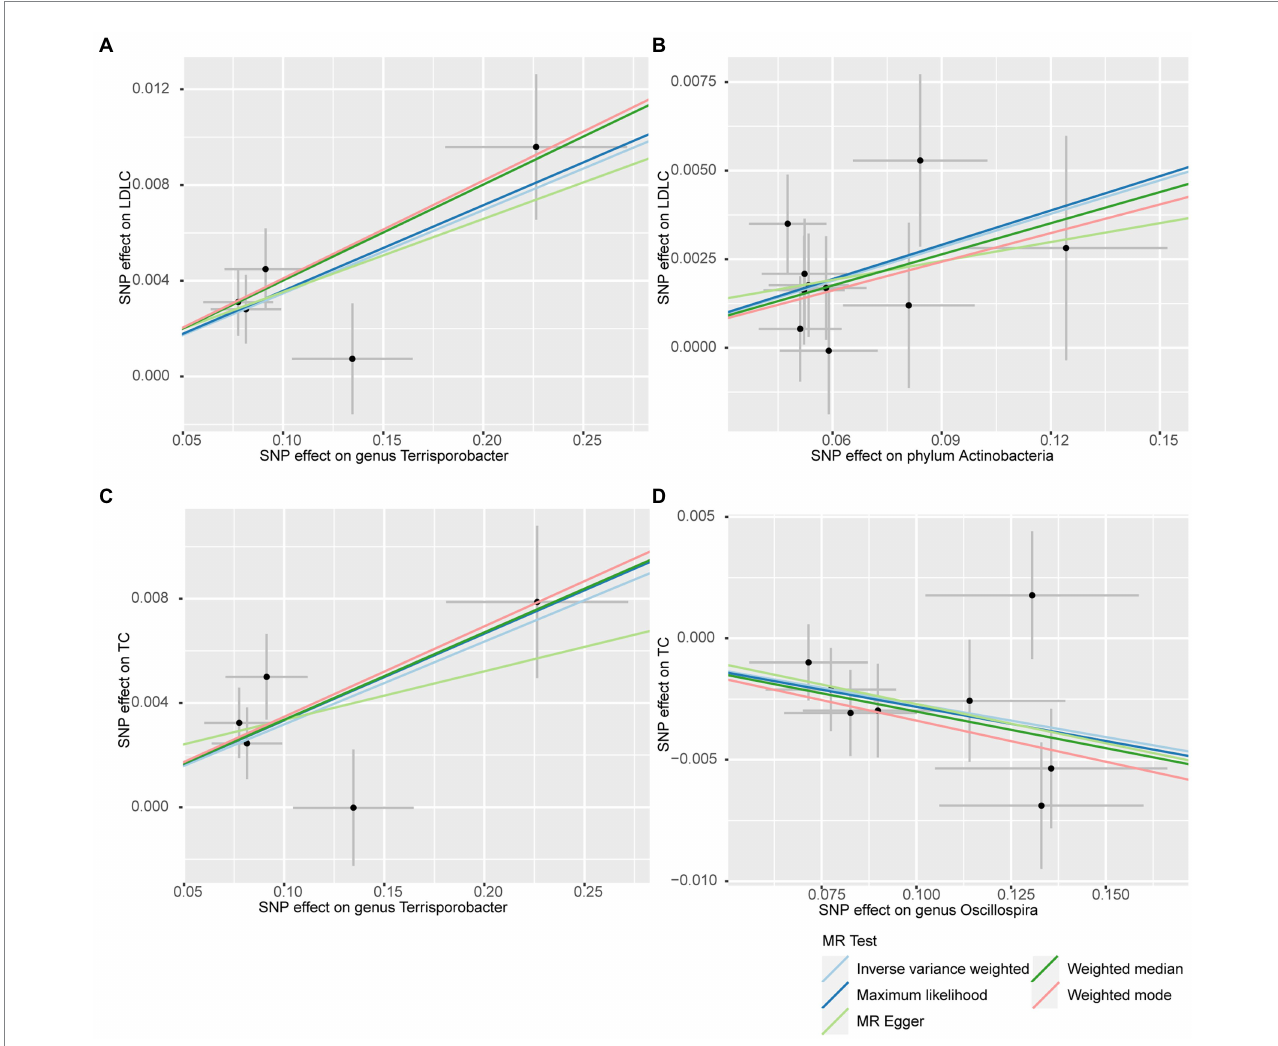
FIGURE 3 Scatter plots for the causal effects of the identified bacterial taxa on serum lipids. (A) Terrisporobacter (genus)–LDL-C. (B) Actinobacteria (phylum)–LDL-C. (C) Terrisporobacter (genus)–TC. (D) Oscillospira (genus)–TG. (Light blue line: inverse-variance weighted; blue line: maximum likelihood; light green line: MR Egger; green line: weighted median estimator; red line: weighted model-based